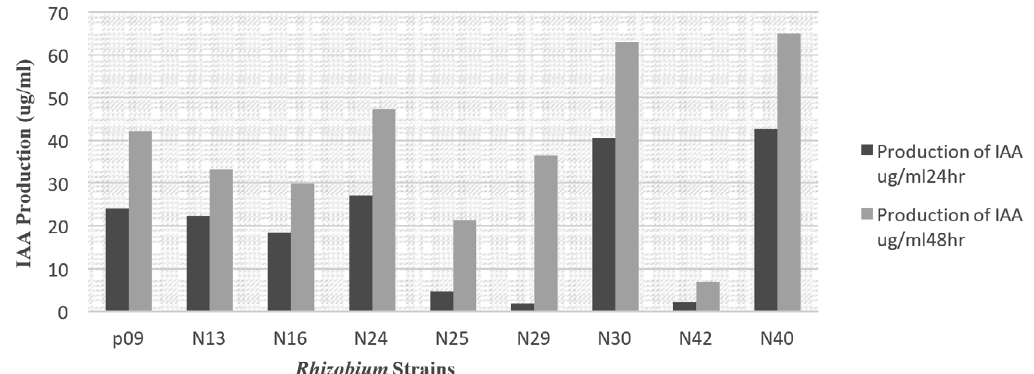
Fig: 3. IAA production by Rhizobium strains after 24 and 48 hours of